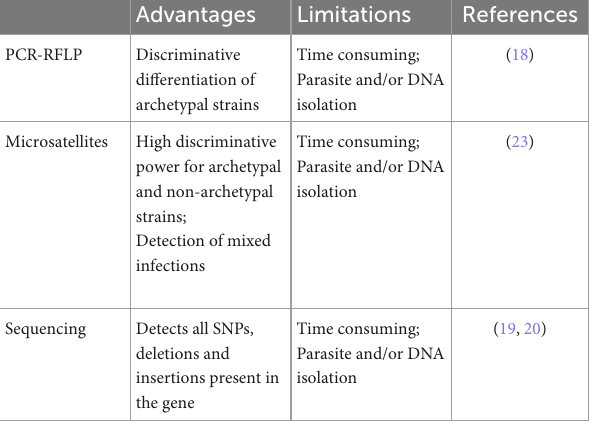
TABLE 2 Antigens from which polymorphic peptides were selected and used for serotyping.